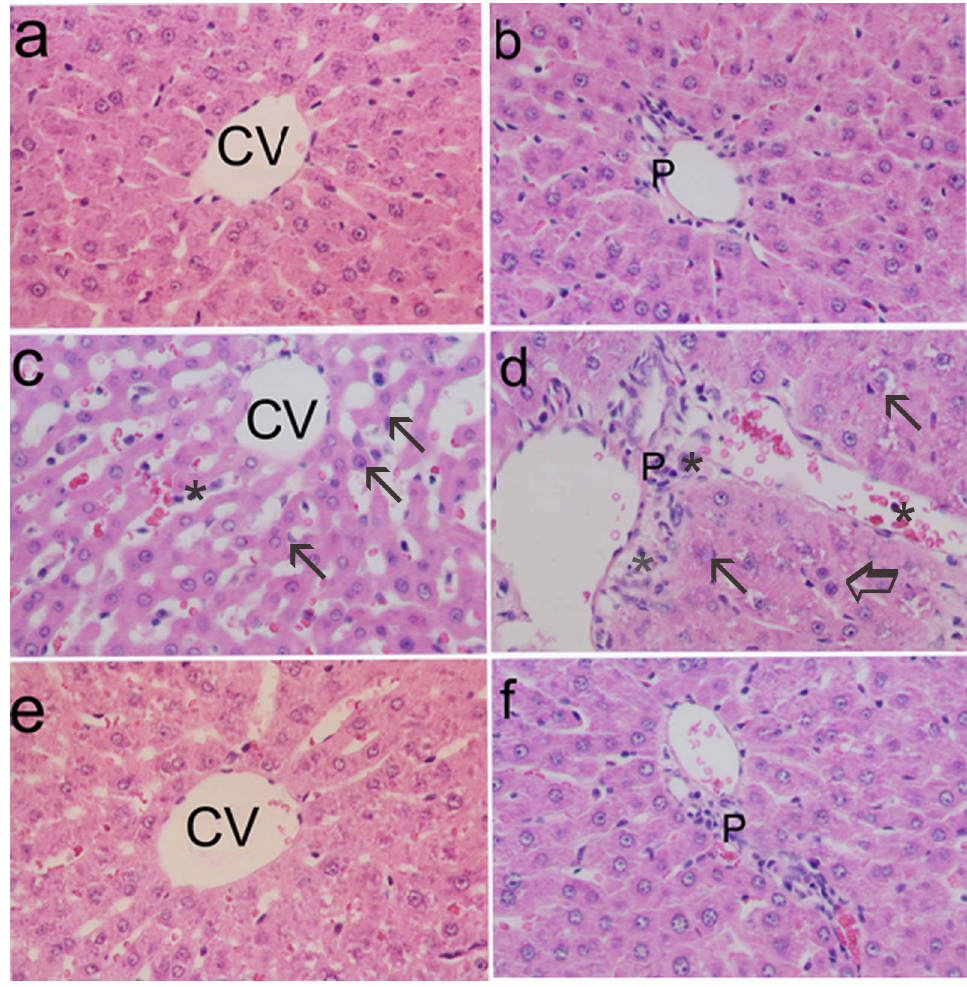
Fig. 4 Photomicrographs of liver sections in central area ( a ) and portal area ( b ) from control rats showing the normal arrangement of hepatocytes. Liver section of KET-treated rats ( c ) showing extensive degeneration of hepatocytes (thin arrows), focal necrosis (thick arrows), and inflammatory cell infiltration * in central vein (cv) and portal area p ( d ). Group of rats pretreated with GEN before KET ( e , f ) exhibiting relatively normal appearance of hepatocytes with moderate degeneration and focal vacuolated cells (H&E, X